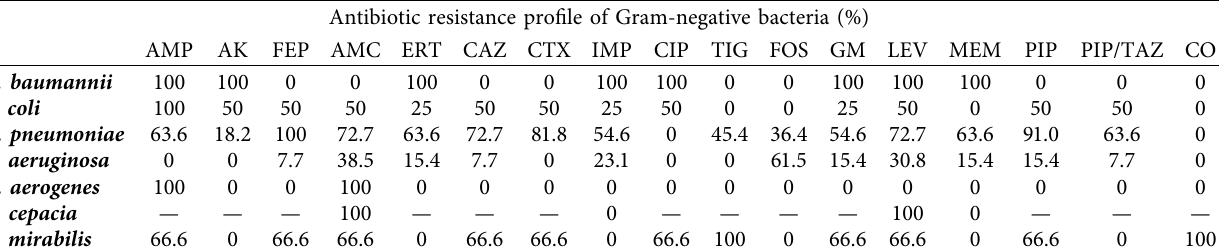
Table 4: Antibiotic resistance profile of Gram-negative bacteria. Antibiotic resistance profile of Gram-negative bacteria (%)